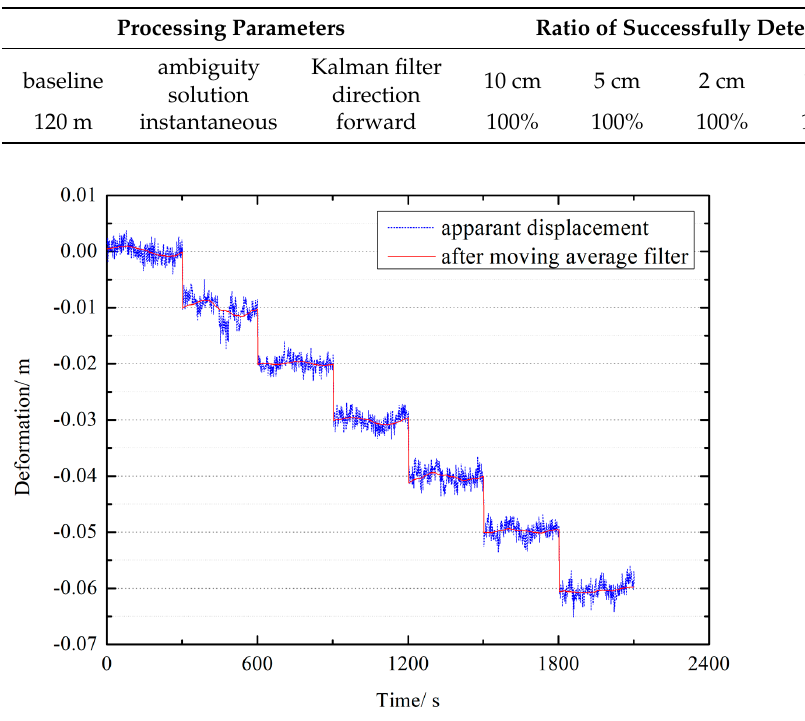
Figure 17. Automated vertical shift detection based on deformation. The antenna of the test site is shifted repeatedly by 1 cm distance. The blue dot line is the deformation derived from the short baseline solution. The red line is the deformation after applying the moving average filter method. Table 5. Evaluation of horizontal shift from 10 cm to 1 cm.